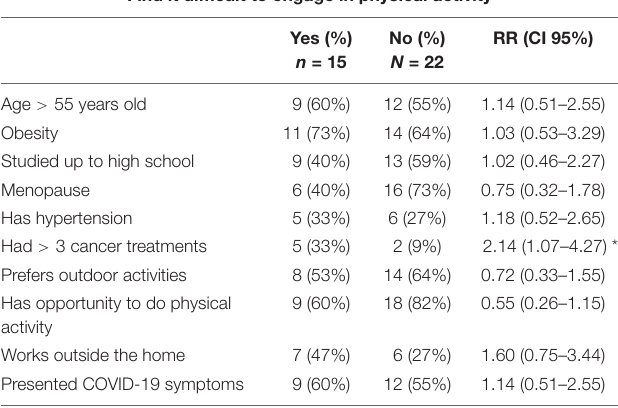
TABLE 3 | Evaluation of factors potentially associated with the perception of the patients that it is difficult to engage in physical activities (Survey taken during the COVID-19 pandemic with breast cancer survivors previously enrolled in a canoeing program, n =